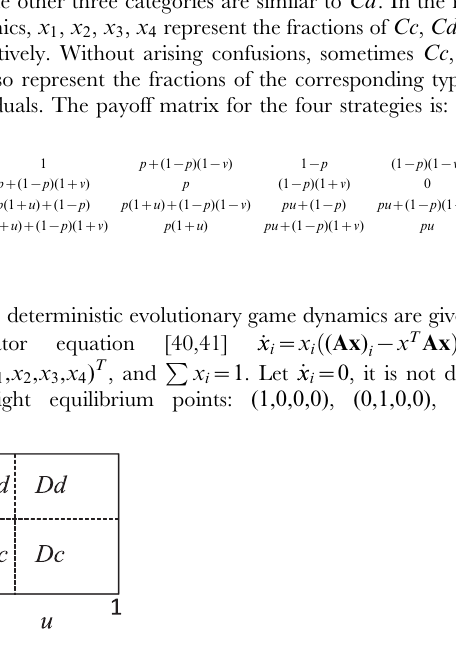
Figure 2. Schematic presentation of u { v parameter plane. Simulation runs with the parameters as u ½ 0,1 (cid:2) step 0 : 05 , v ½ 0,1 (cid:2) step 0 : 05 .